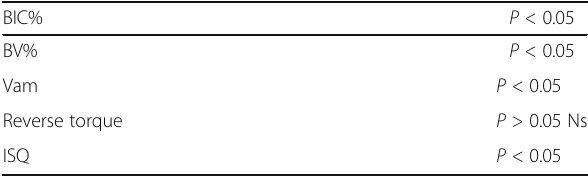
Table 3 Statistical comparison ( T test) of examined parameters between the test and control groups. The histomorphometric analysis demonstrated significant differences in BIC% and %BV values between the two implant